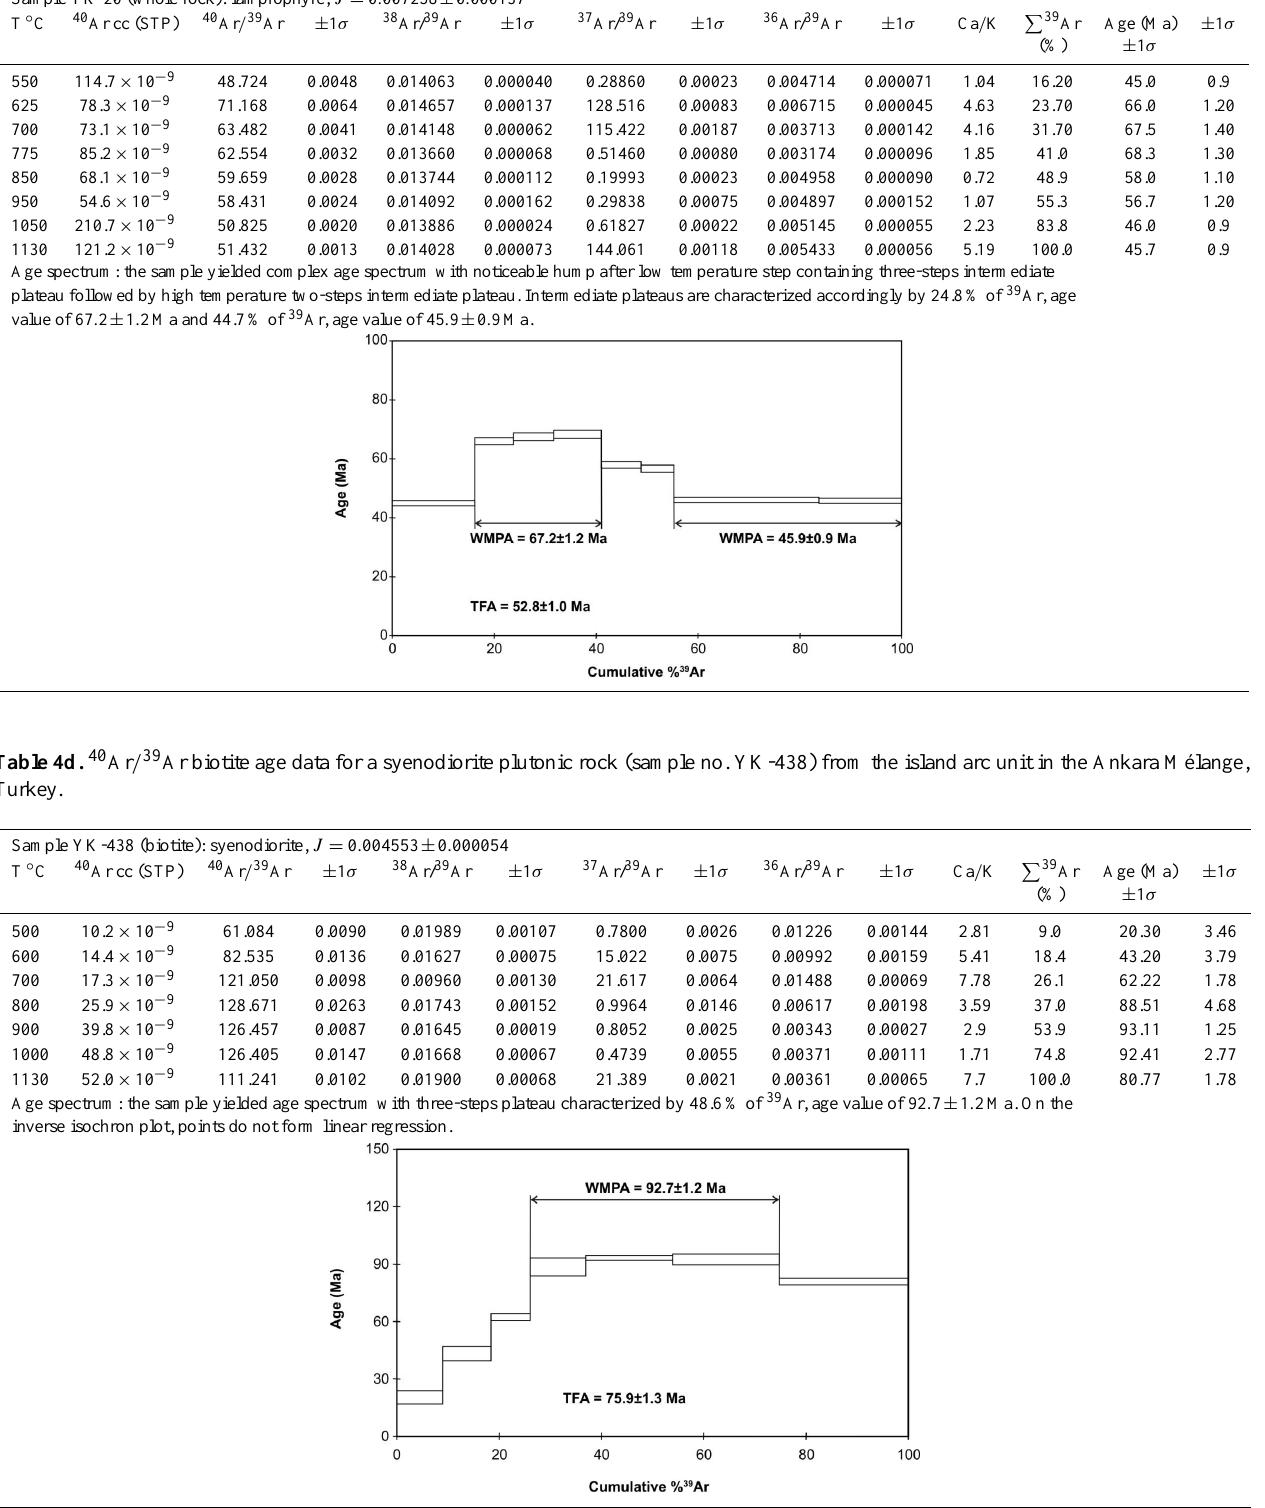
Table 4c. Whole-rock 40 Ar/ 39 Ar age data for a lamprophyre dike (Sample No. YK-20) from the island- arc unit in the Ankara Mélange, Turkey. 972 Sample: YK- 20 (whole rock): Lamprophyre, J=0.007258 ± 0.000137